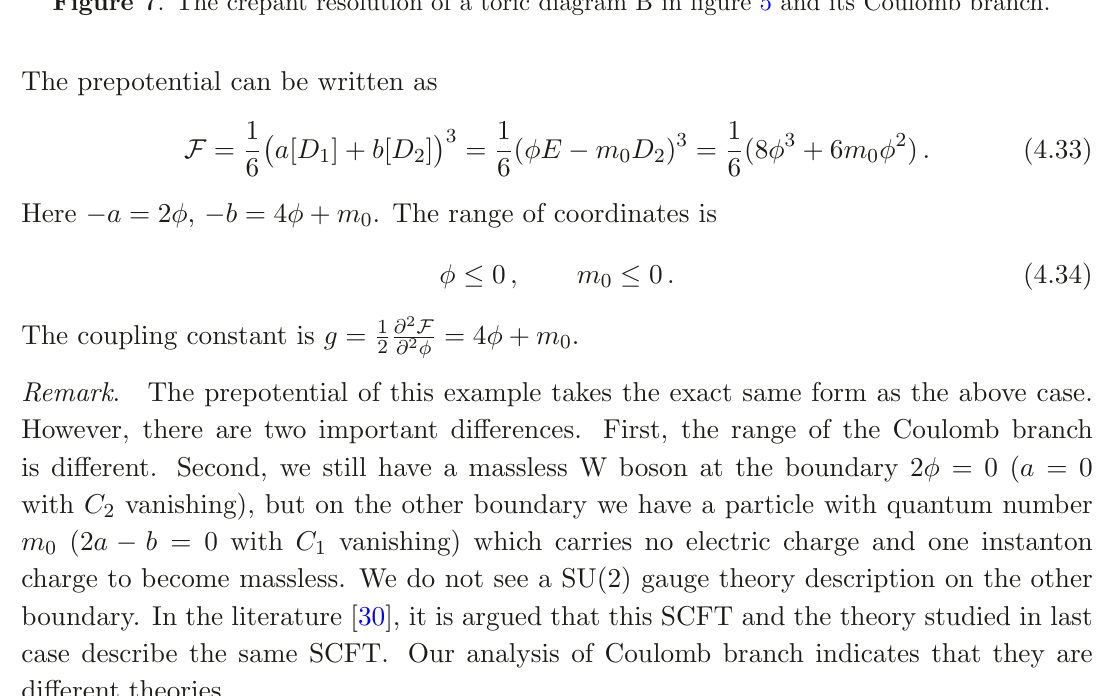
Figure 7 . The crepant resolution of a toric diagram B in figure 5 and its Coulomb